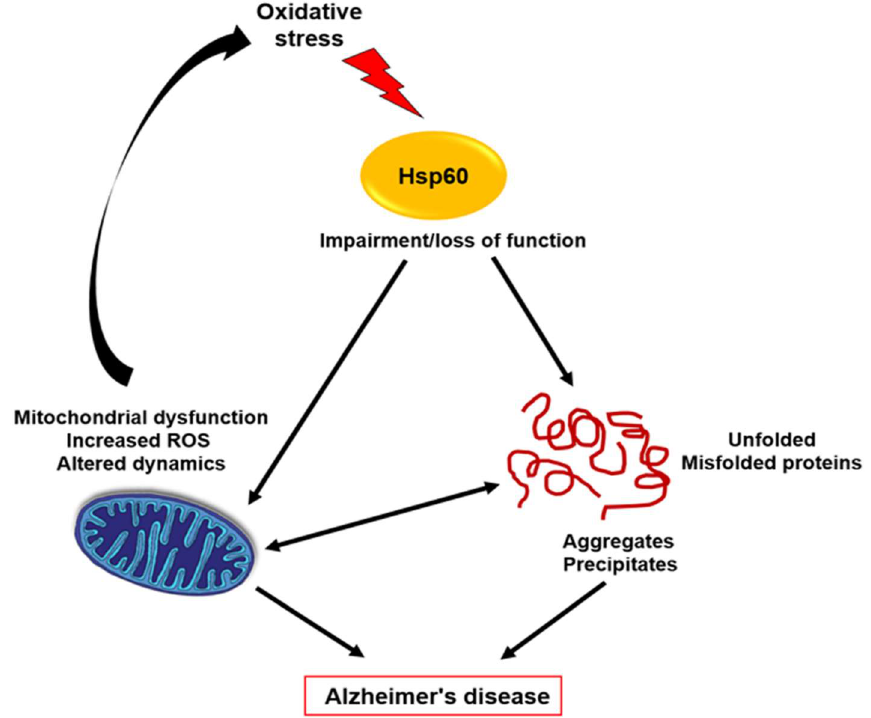
Figure 1. Hsp60 and Alzheimer’s disease. Oxidative stress may cause Hsp60 structure modifications leading to loss of Hsp60 functions with the consequences of protein misfolding, aggregation and deposition.